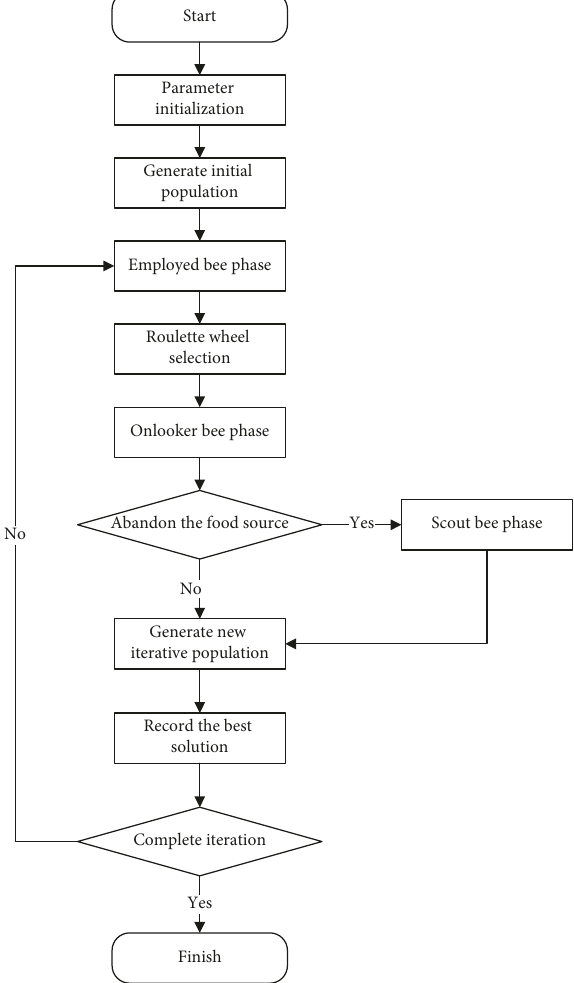
Figure 1: Schematic of the ABC